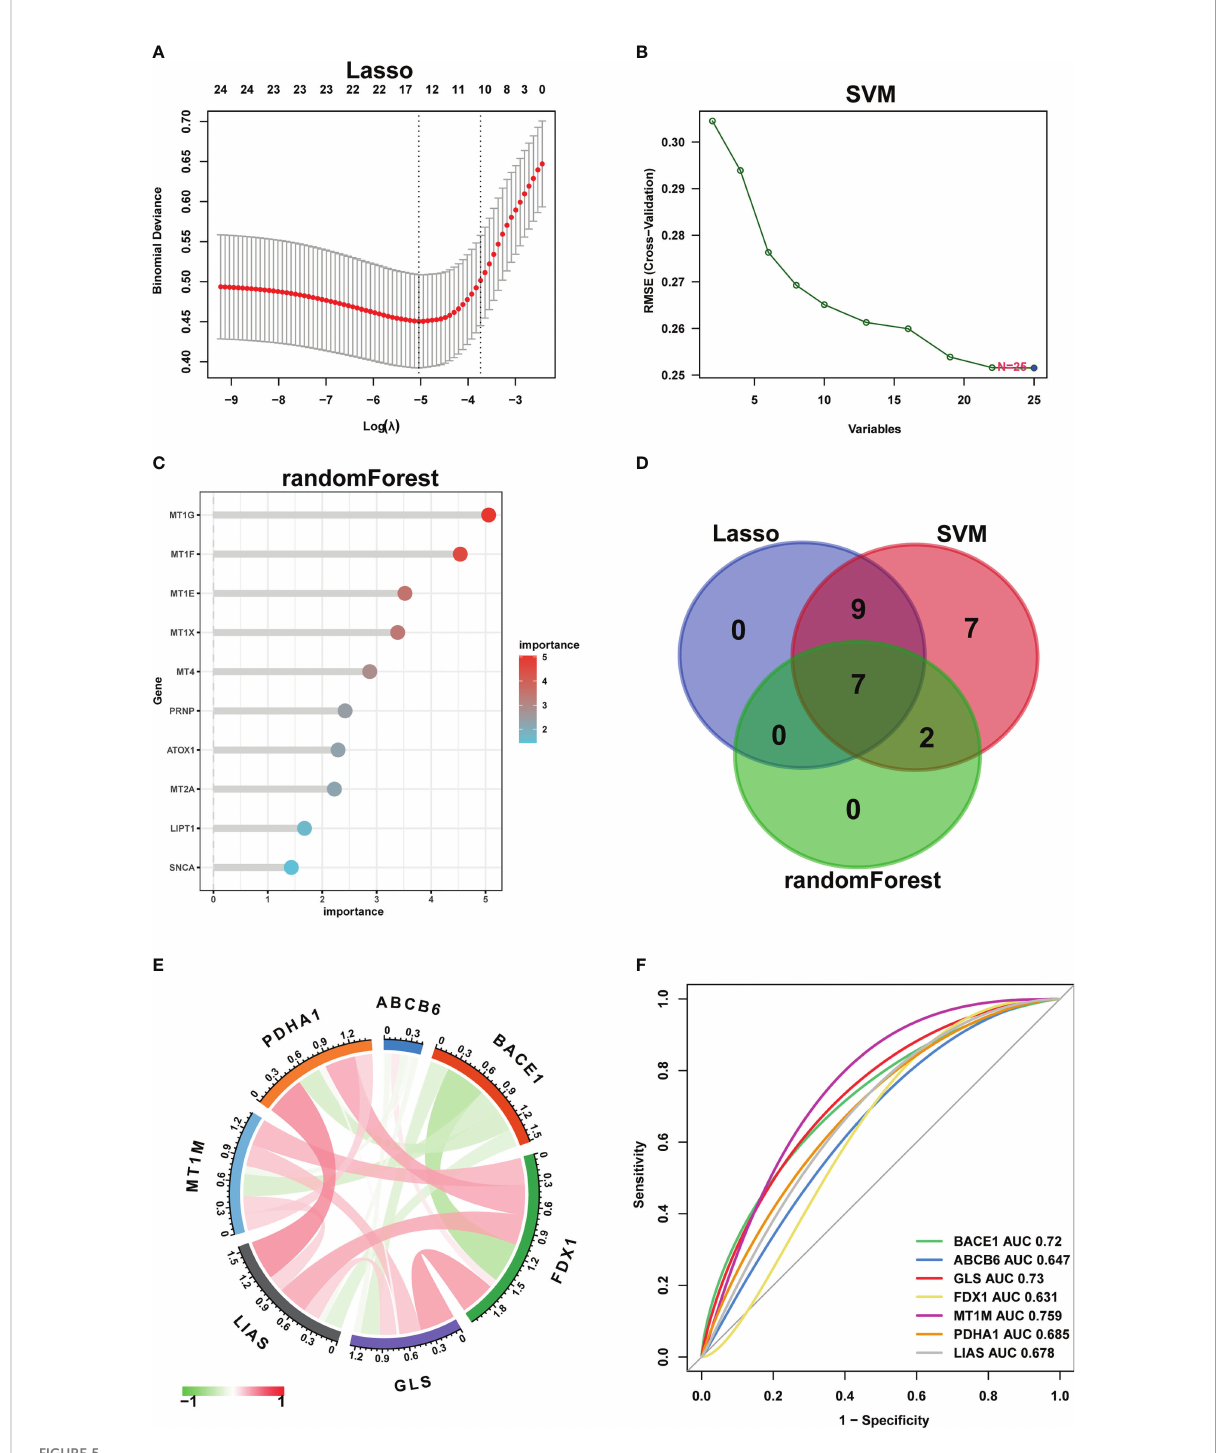
FIGURE 5 Machine learning in the identi fi cation of cuproptosis-signature. (A – C) Construction of cuproptosis-signatures using LASSO regression, SVM, and RF algorithm. (D) The Venn diagram shows the overlap of candidate genes between the above three algorithms. (E) Circos plot displaying the relationship between the overlapping cuproptosis genes. (F) ROC curve of cuproptosis-signatures in CD diagnosis. LASSO, least absolute shrinkage and selection operator; SVM, support vector machine; RF, random forest; ROC, receiver operating